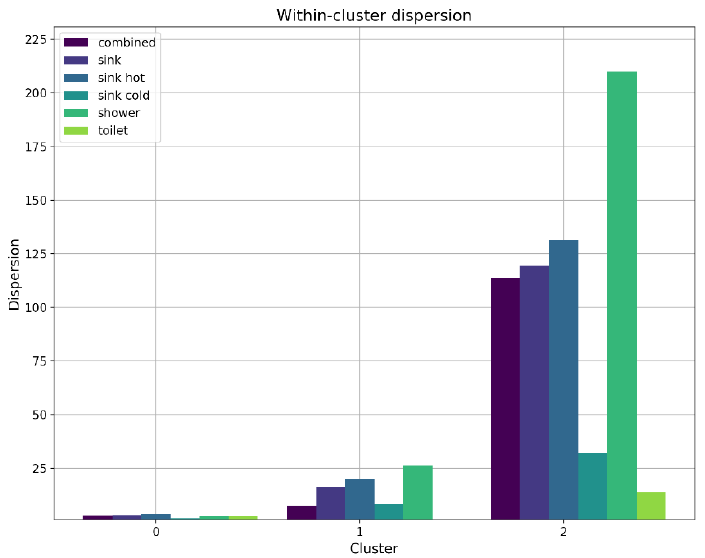
Figure 10. The evaluation of within-cluster dispersion.